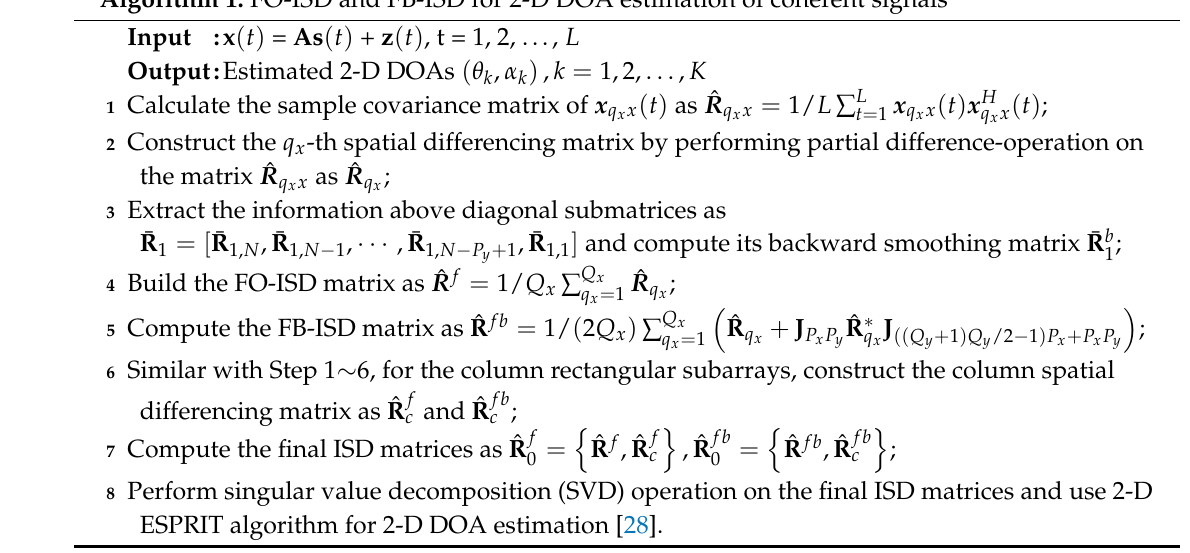
Algorithm 1: FO-ISD and FB-ISD for 2-D DOA estimation of coherent